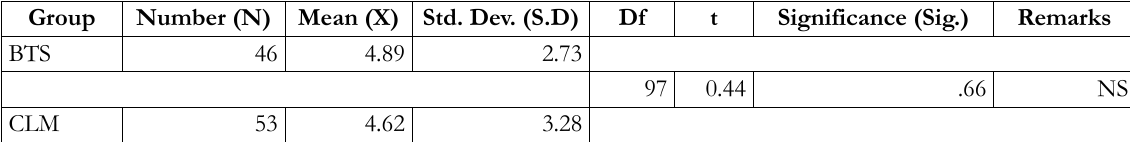
Table 2. T-test analysis of the Pre-test